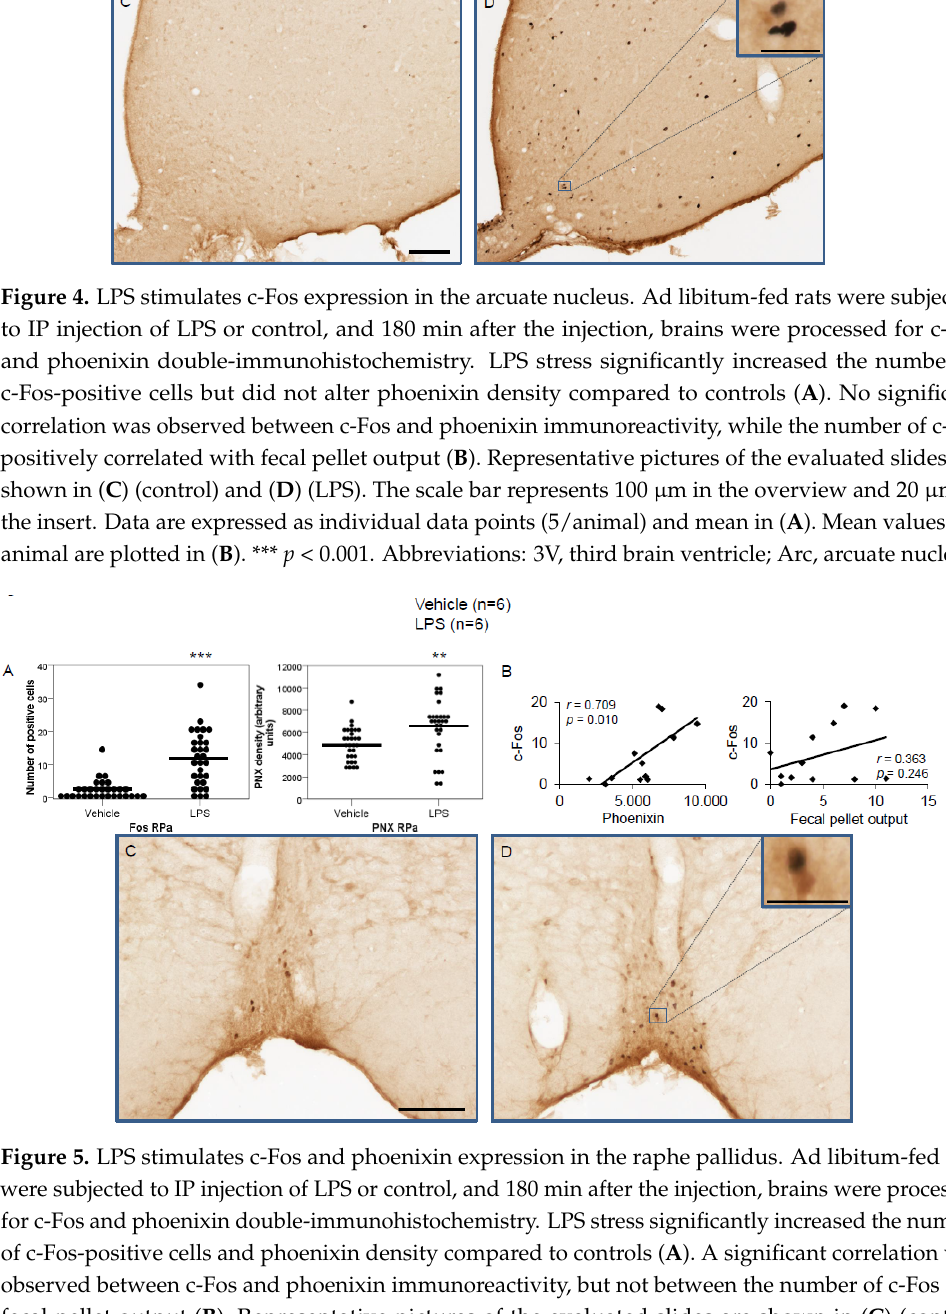
Figure 5. LPS stimulates c-Fos and phoenixin expression in the raphe pallidus. Ad libitum-fed rats were subjected to IP injection of LPS or control, and 180 min after the injection, brains were processed for c-Fos and phoenixin double-immunohistochemistry. LPS stress significantly increased the number of c-Fos-positive cells and phoenixin density compared to controls ( A ). A significant correlation was observed between c-Fos and phoenixin immunoreactivity, but not between the number of c-Fos and fecal pellet output ( B ). Representative pictures of the evaluated slides are shown in ( C ) (control) and ( D ) (LPS). The scale bar represents 100 µ m in the overview and 20 µ m in the insert. Data are expressed as individual data points (5/animal) and mean in ( A ). Mean values per animal are plotted in ( B ). ** p < 0.01, *** p < 0.001. Abbreviations: py, pyramidal tract; RPa, raphe